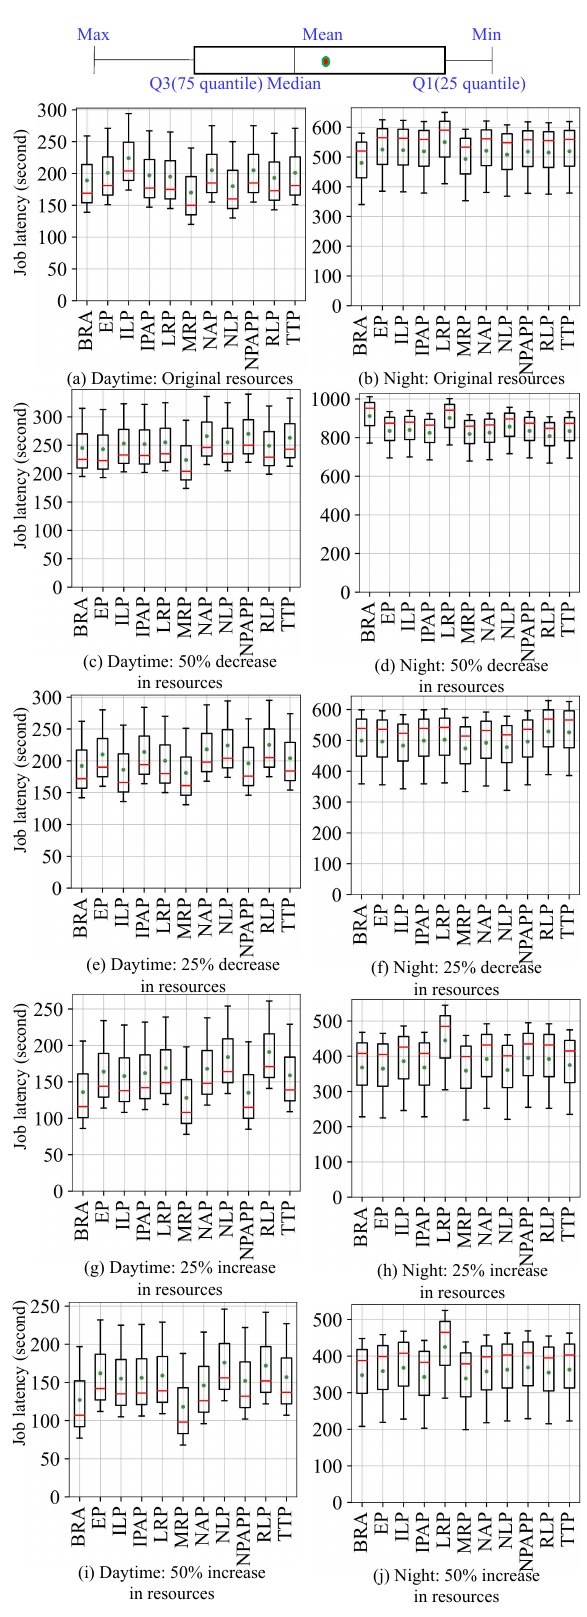
Figure 8. Simulation: TaskQueue